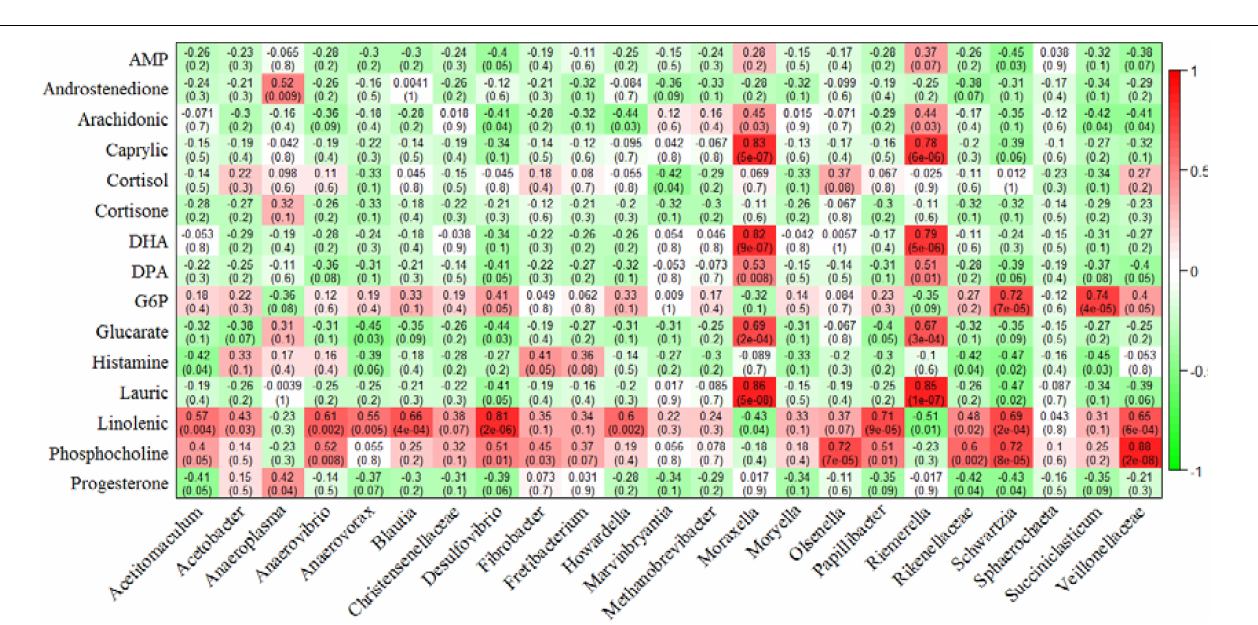
FIGURE 5 | Comparison of the classification of rumen microbiota between two groups by linear discriminant analysis effect size (LefSe) method. The LDA value distribution histogram (left) shows the species with significant differences in abundance in the two groups, and the length of the histogram represents the impact of different species. In the taxonomic cladogram (right), the circles radiating from the inside to the outside represent the classification level from phylum to species. Taxa with enriched levels in CN are shown in red, whereas those with enriched levels in RE are shown in green. The species names indicated by the letters in the picture are shown in the legend on the right.